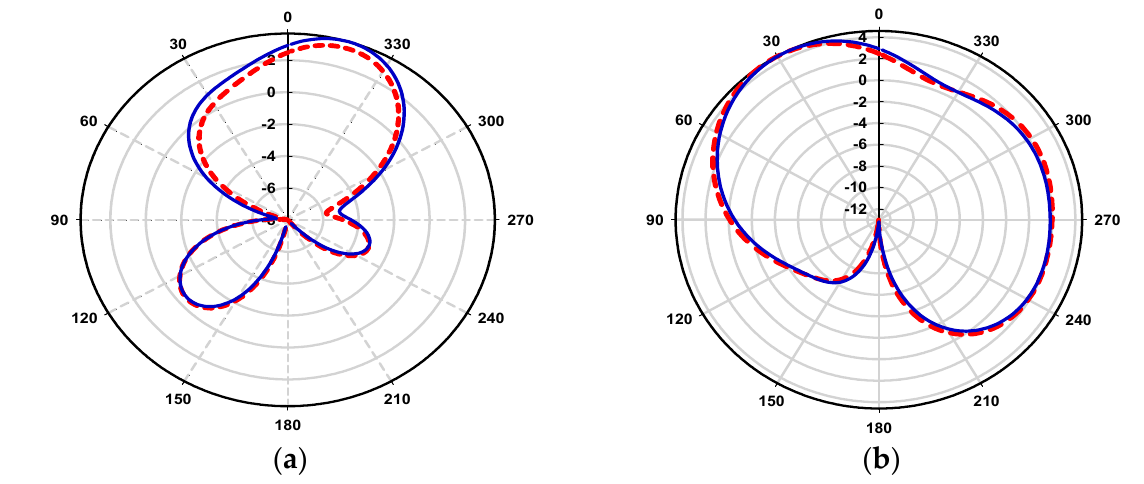
Figure 16. Simulated and measured radiation pattern at 13.13 GHz in ( a ) XY plane (E-field), and ( b )